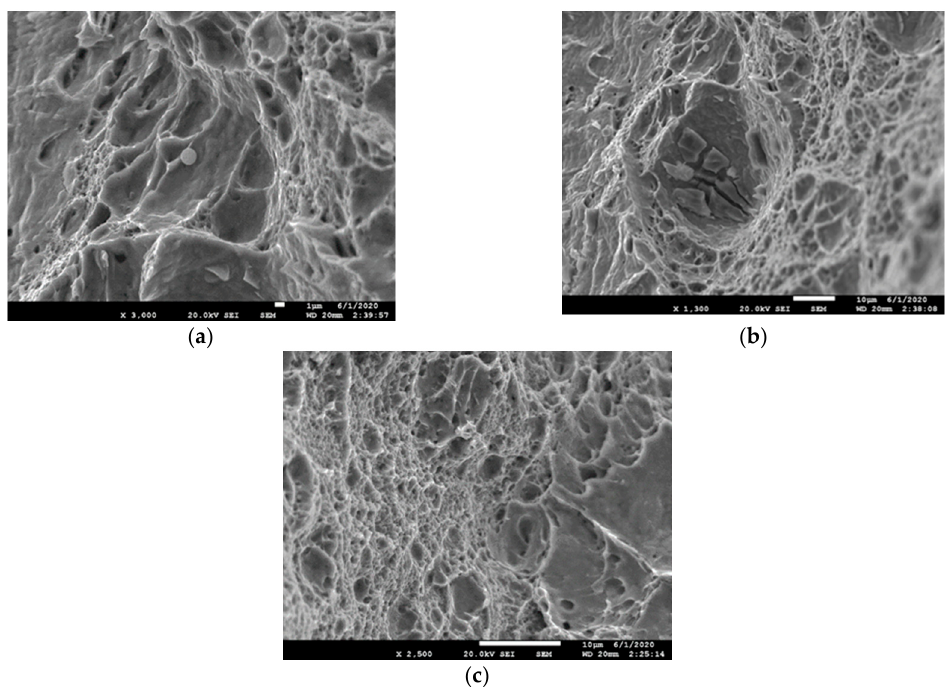
Figure 10. The fractured surface of the hexagonal family 2 (samples 22–24) with ( a ) mixed-mode brittle and ductile fracture, ( b ) oxide residues, and ( c ) ductile ridges and dimples.